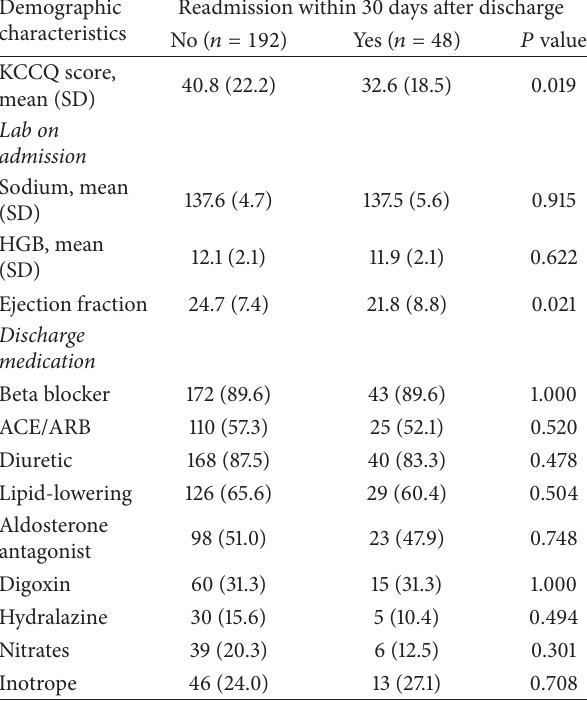
Table 2: Summary of KCCQ score, lab tests, and discharge medica- tion between HF readmission and nonreadmission within 30 days after